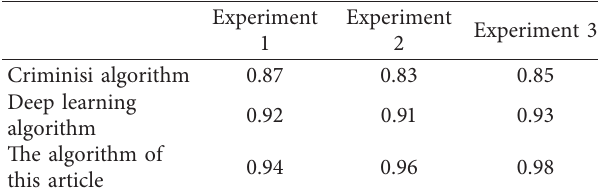
Table 2: Comparison of SSIM effects of three repair algorithms.